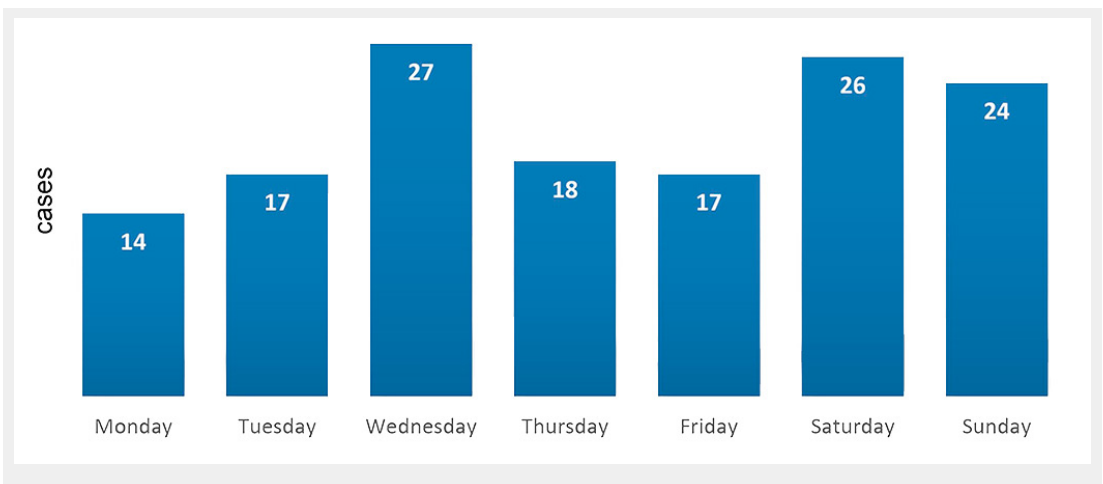
Figure 4 Distribution of cases per weekday. Case numbers are depicted according to the day of the